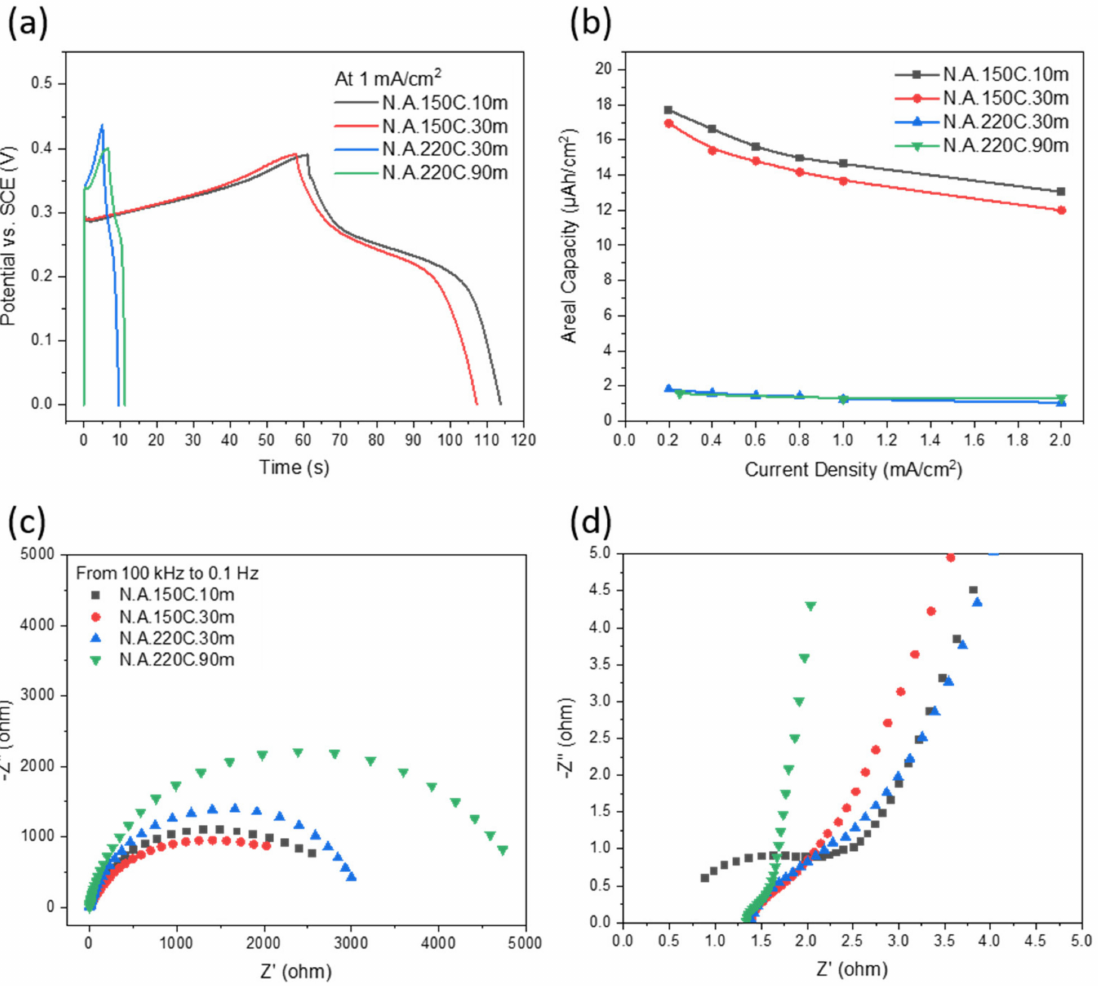
Figure 7. ( a ) GCD curves at a current density of 1 m A/cm 2 ; ( b ) areal capacity functions of current densities; ( c , d ) Nyquist plots from EIS with enlarged